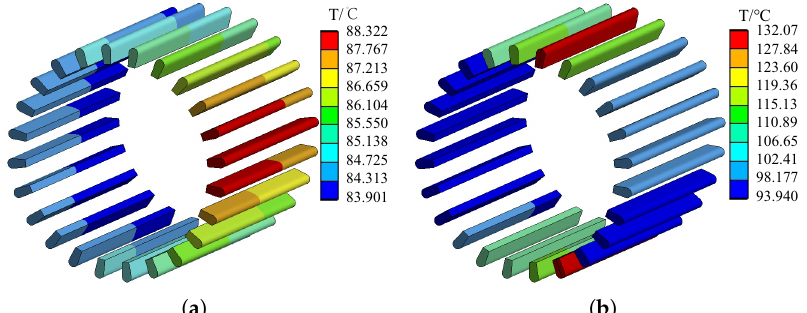
Figure 9. Winding temperature distributions of normal and faulty motor. ( a ) Normal. ( b ) Forty-five- turn fault.